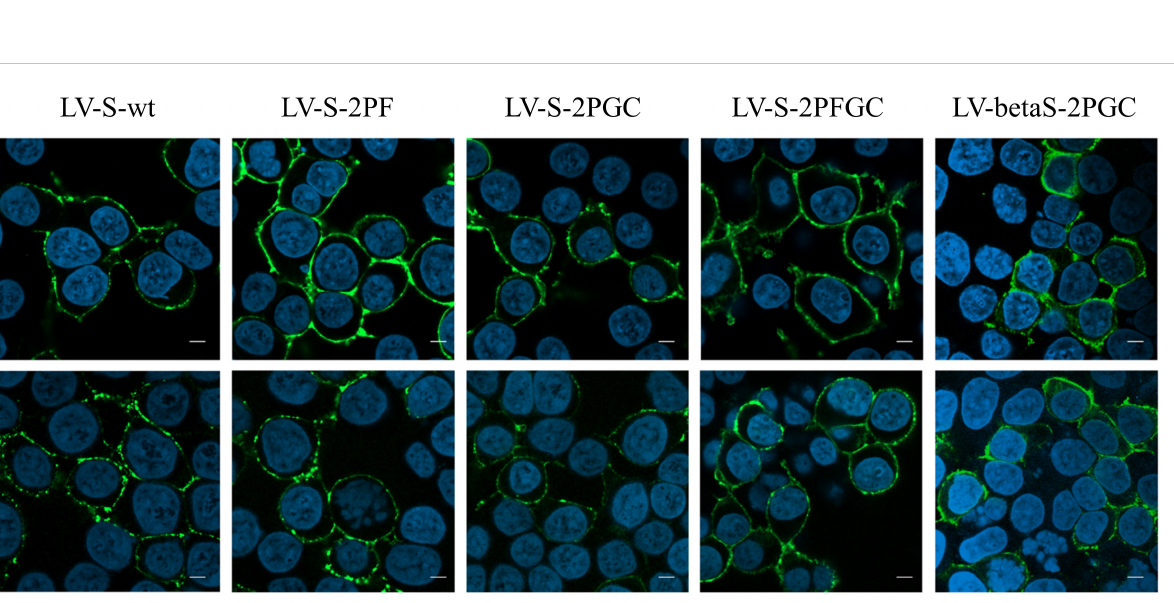
FIGURE 2 Spike expression from lentiviral vectors. Analysis by CLSM of 293T Lenti-X cells transduced with the indicated lentiviral vectors expressing the different Spike conformations. Cells were stained with anti-RBD COVA2-15 or COVA1-16 human mAbs followed by anti-human IgG Alexa Fluor 488 as secondary Ab (green). Nuclei were stained in blue with DAPI. Two images representing single central optical sections are shown for each sample. Shown are results from one representative of n = 3 experiments. Scale bar is 10 m m.